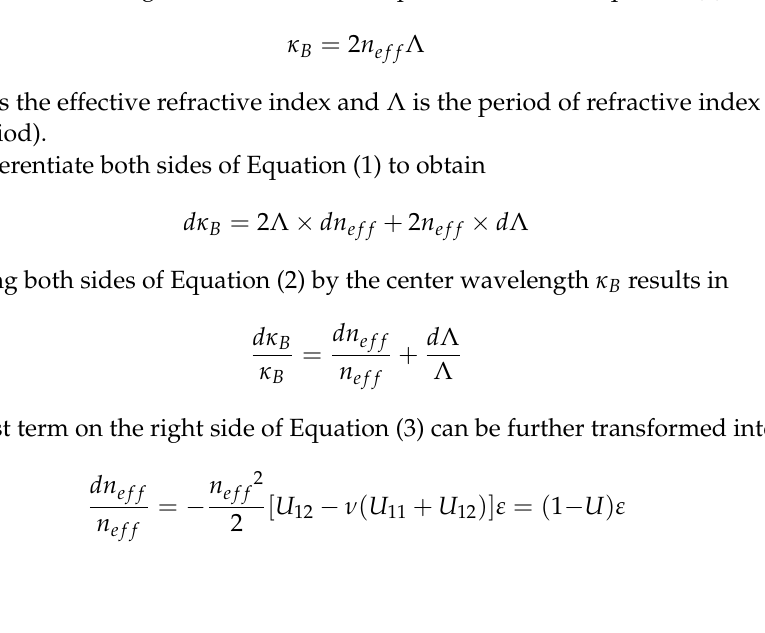
Figure 1. The working principle of a fiber Bragg grating (FBG) sensor. The central